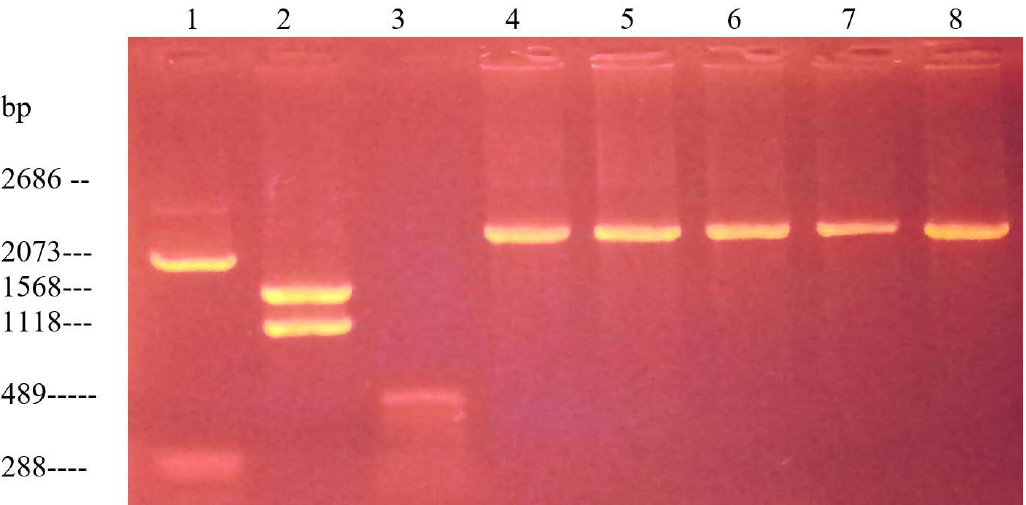
Fig. 2. Electrophoregram of DNA markers and isolated DNA plasmid of field isolates of S. enteritidis : 1– plasmid marker pUC19, digested with the enzyme Mva I (2686, 2073,288 bp); 2 - plasmid marker pUC19, digested with the enzyme Bgl I (1568, 1118 bp); 3 - plasmid marker pUC19, digested with with the enzyme Msp I (489 BP); 4 - S. enteritidis 16/78; 5 - S. enteritidis 22/114; 6 - S. enteritidis 26/145; 7 - S. enteritidis 29 / 171a; 8 - S. enteritidis 45/265